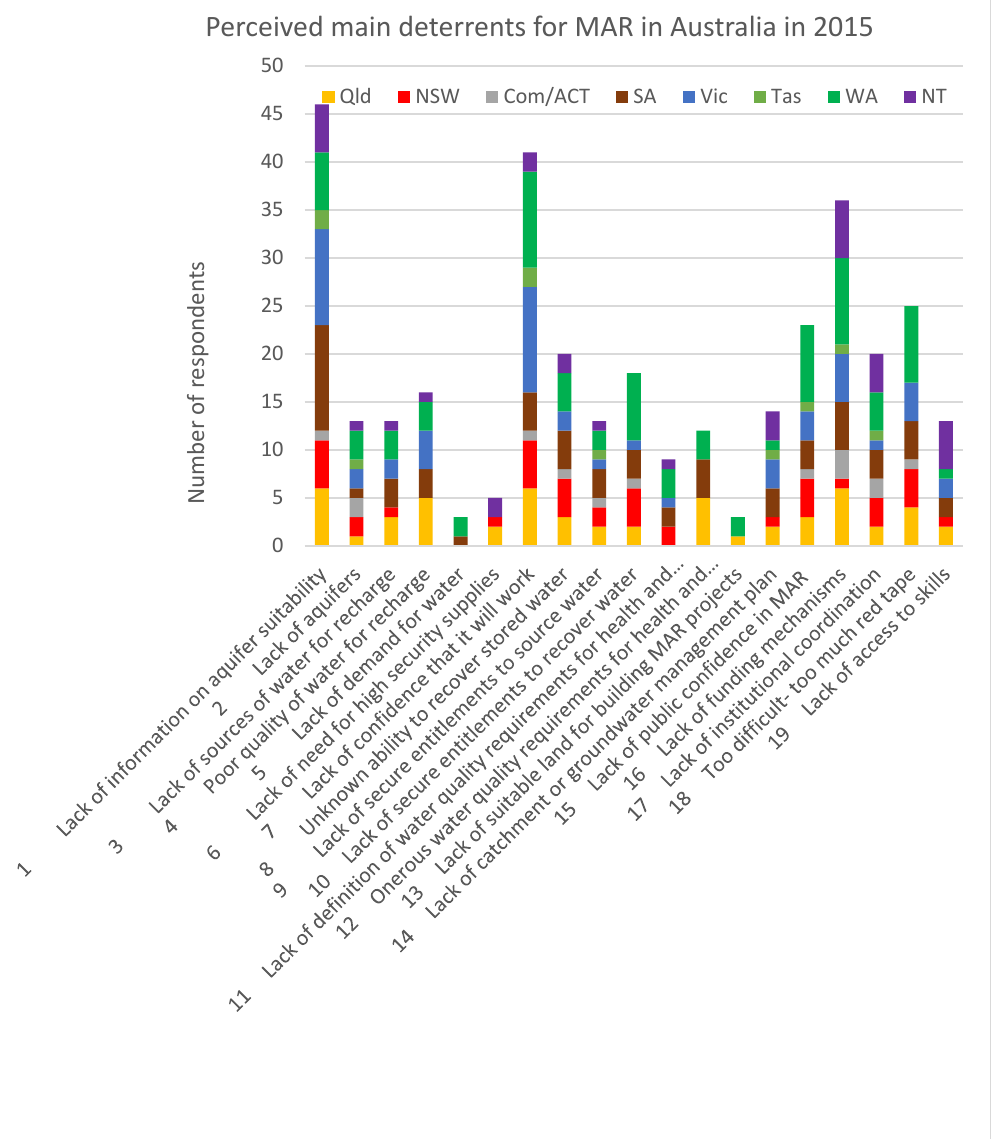
Figure 4. Number of respondents reporting perceived importance of each identified factor deterring MAR in their jurisdiction (NCGRT survey 2015). (Total number of respondents = 134, total responses = 343, and average number of responses per category = 18.)